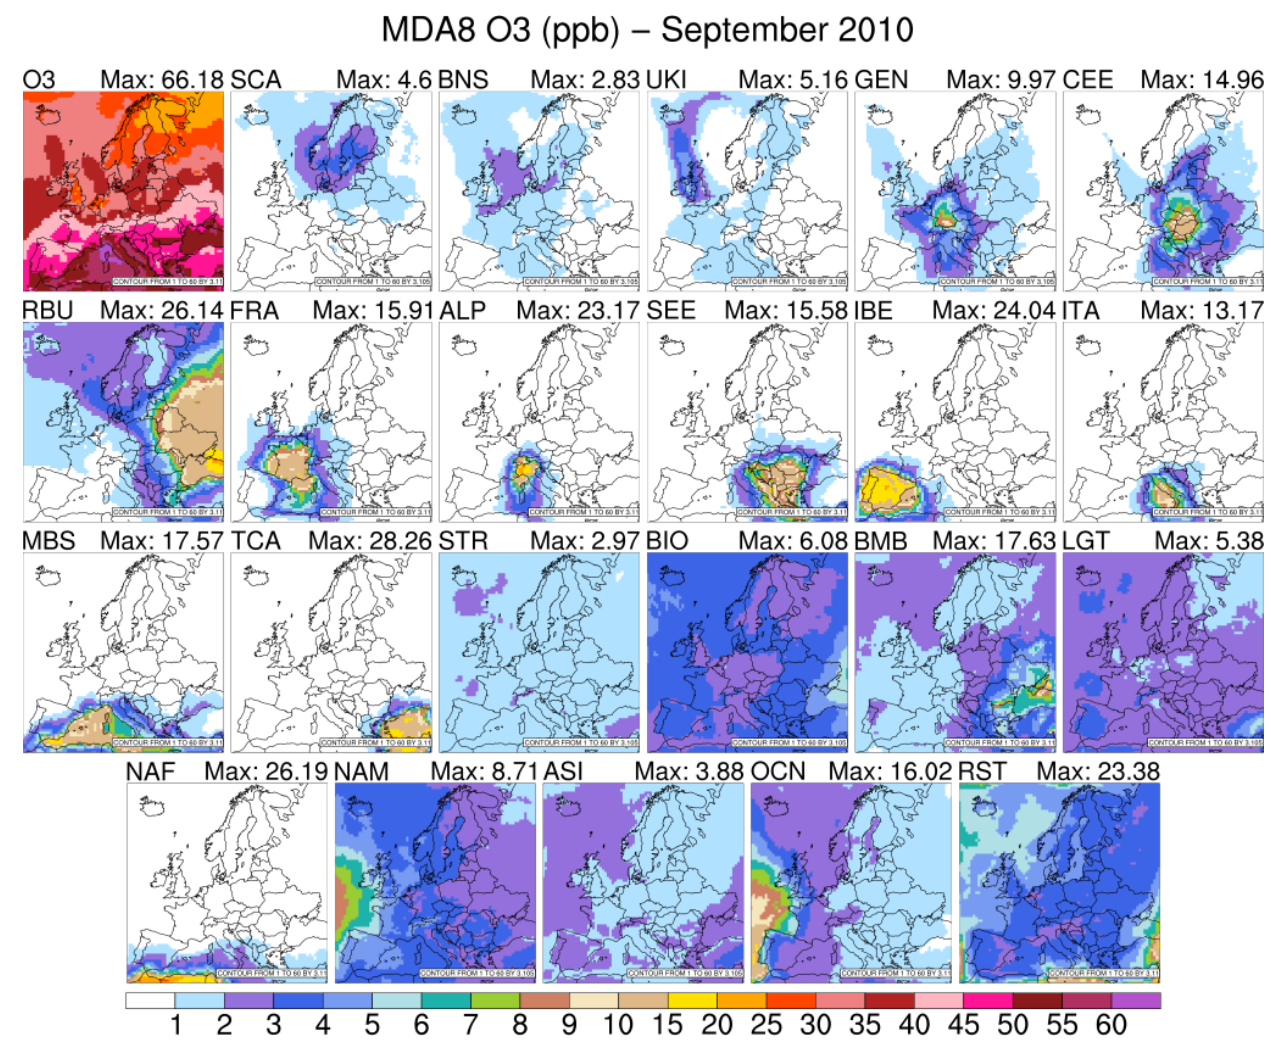
Figure 4. Same as Fig. 2, but for September